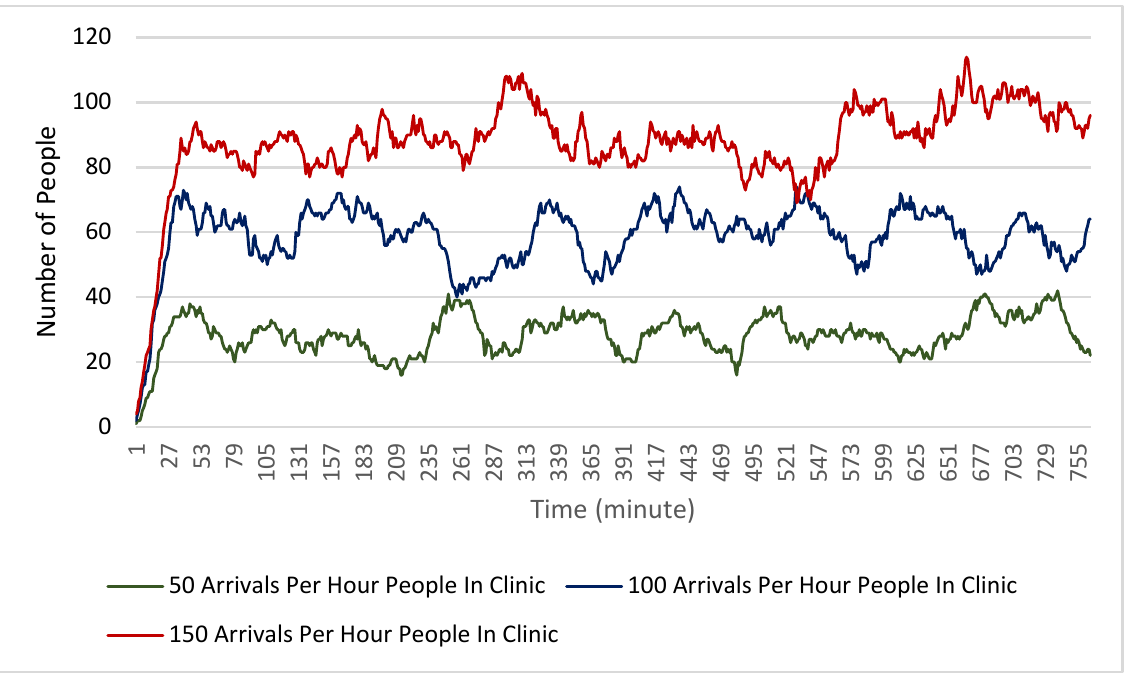
Figure 9. Total number of people in the clinic at each minute during the simulation for each of the arrival rate scenarios with physical distancing.